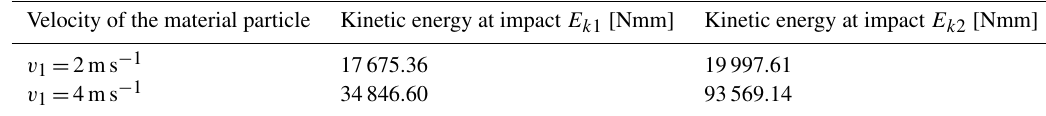
Table 3. Values of the kinetic energy for selected velocities v 1 .